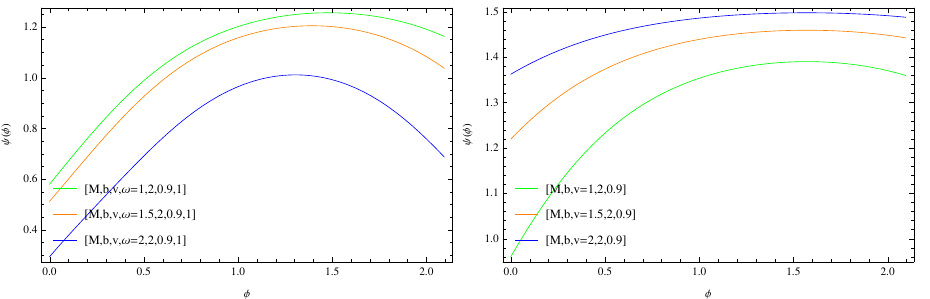
Figure 3. ( left ) The variation in the angle between radial direction and direction of the particle motion is shown, i.e., ψ ( φ ) against φ for different values of the impact parameter b . ( right ) ψ ( φ ) is shown against φ for different values of the impact parameter b for Schwarzschild case.